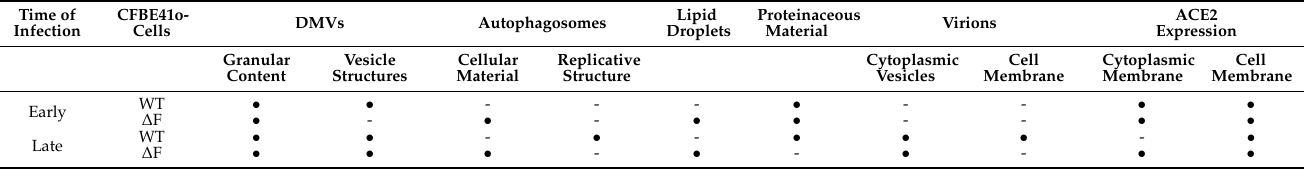
Table 1. Description of main morphological characteristics in SARS-CoV-2-infected CFBE41o- WT and ∆ F cells in early and late stages of